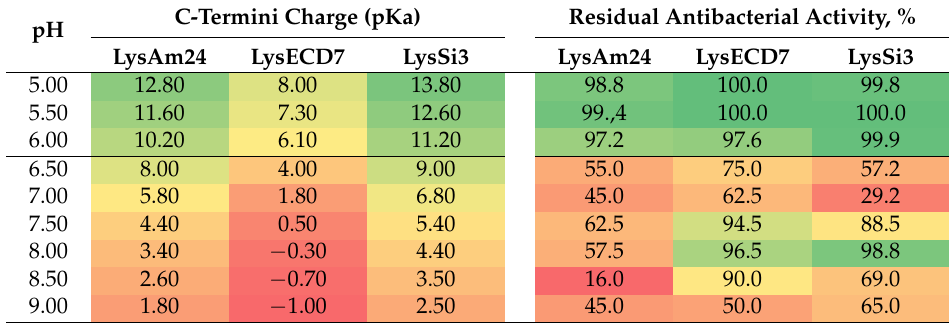
Table 3. Heatmap of estimated endolysin C-termini charges over the pH range and the residual antibacterial activity within this range (http://protcalc.sourceforge.net/). Min to Max pKa and residual activity is indicated with the color scale from red to green background. For all experiments, the mean values of three independent experiments are